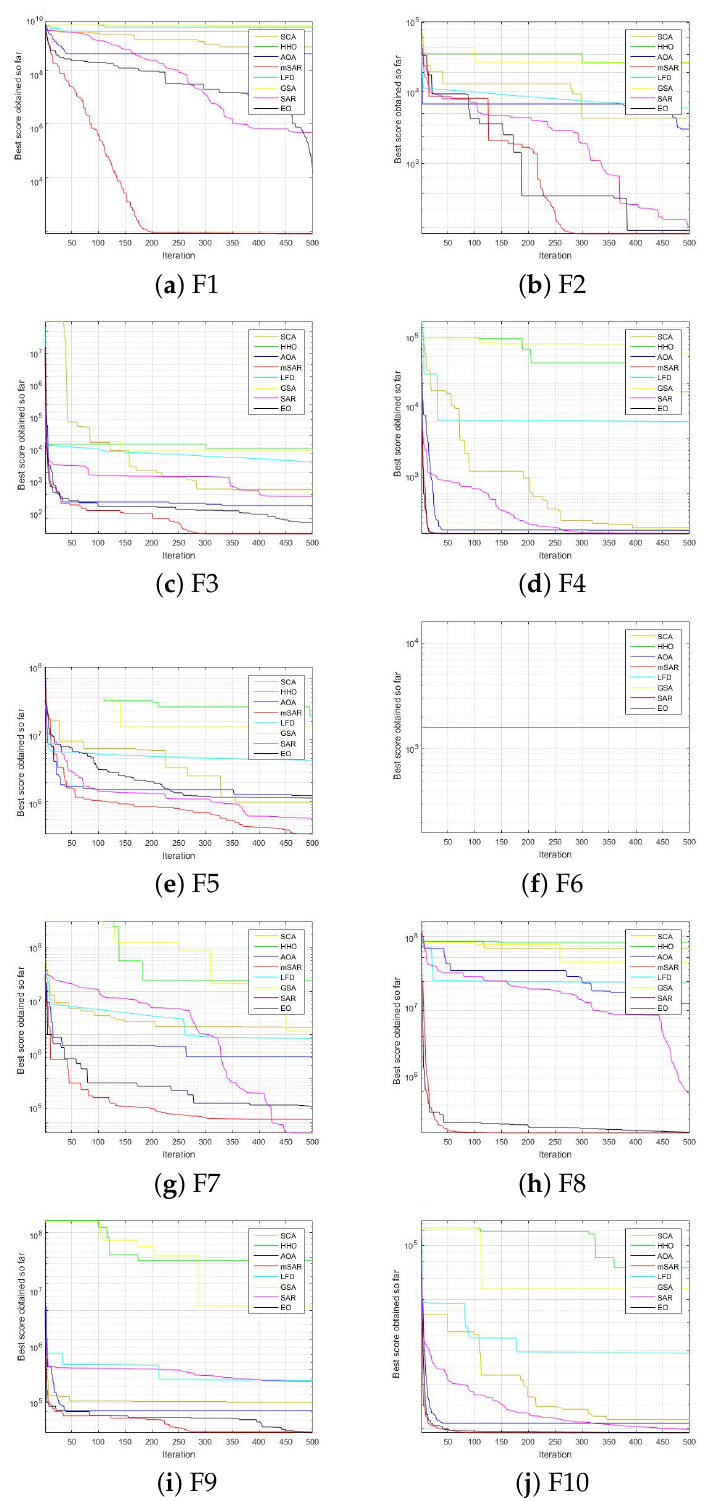
Figure 5. The convergence curves of the proposed mSAR algorithm with other competitive algorithms over CEC’2020 functions with D =